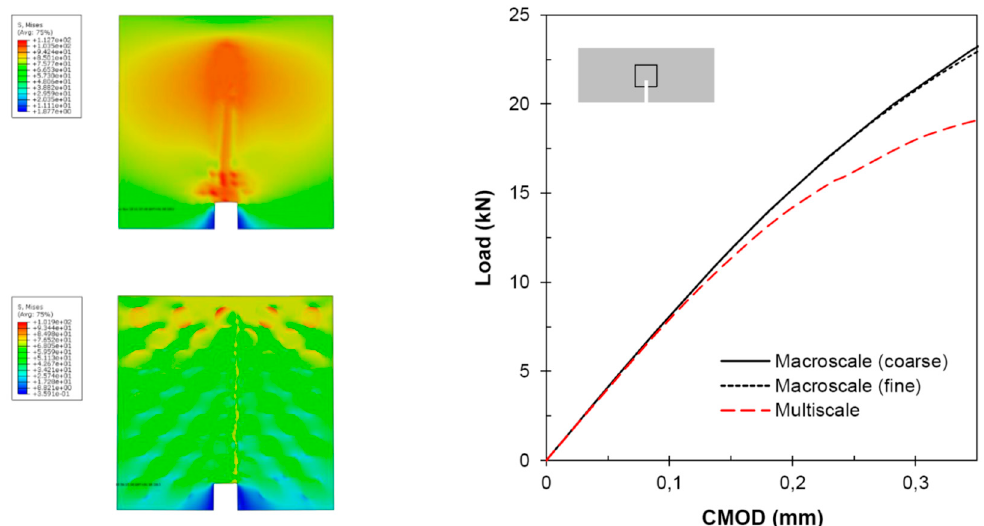
Figure 22. Domain decomposition should not be mistaken with mesh refinement. Figure ( a , b ) show a macroscale model with coarse and fine meshes, while a multiscale domain with macroscale ( c ) and microscale ( d ) subdomains may have different mesh density.